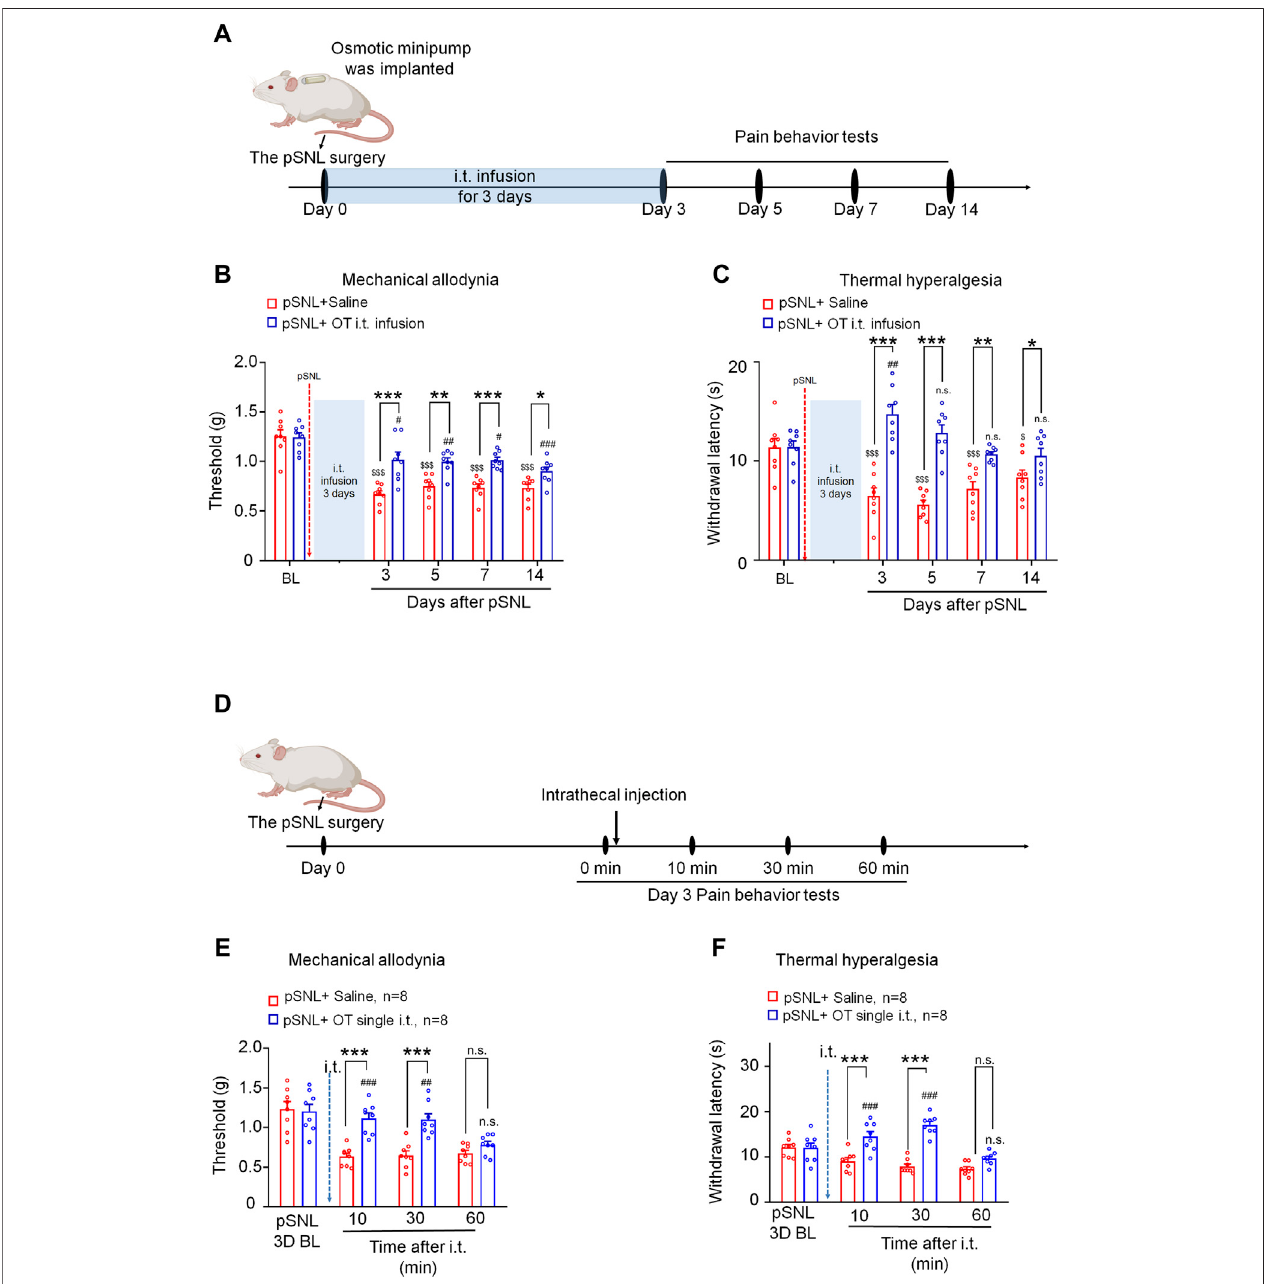
FIGURE1| Three-daycontinuousintrathecalinfusion,butnotshort-termapplicationofOT,attenuatedtheestablishmentanddevelopmentofnerveinjury-induced nociceptive behaviours in pSNL mice. (A) A schematic of the experimental design. (B,C) Continuous intrathecal OT infusion (0.3 μ g/100 μ L) for 3 days before behaviouraltestsdecreasedpSNL-inducedmechanicalallodynia (A) andthermalhyperalgesia (B) for14 days. (D) Aschematicoftheexperimentaldesign. (E,F) Asingle intrathecalOTinjection(0.1 μ g/10 μ L)relievedpSNL-inducedmechanicalallodynia (E) andthermalhyperalgesia (F) inmice.Two-wayrepeated-measuresANOVA with group as the between-subjects factor and day/time as the within-subjects factor. Data are expressed as mean ± SEM. * p < 0.05, ** p < 0.01, *** p < 0.001 OT vs . saline; $ p < 0.05, $$$ p < 0.001 vs. baseline; # p < 0.05, ## p < 0.01, #### p < 0.0001 vs. baseline.